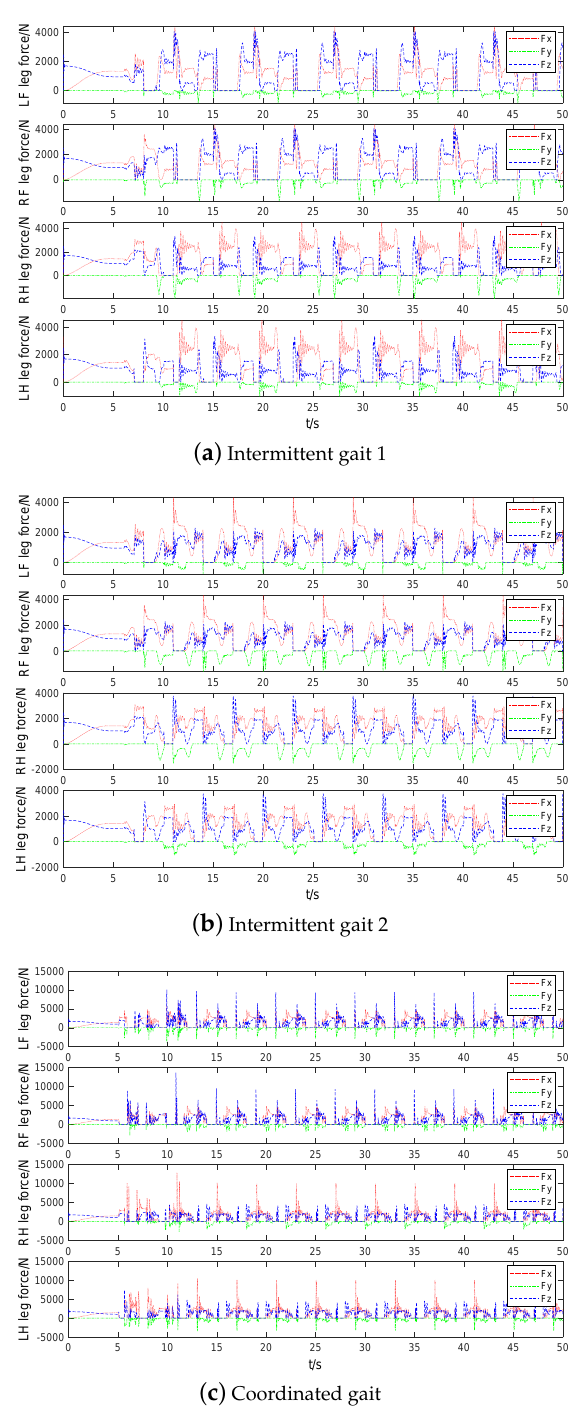
Figure 13. Comparison of foot contact force of three static